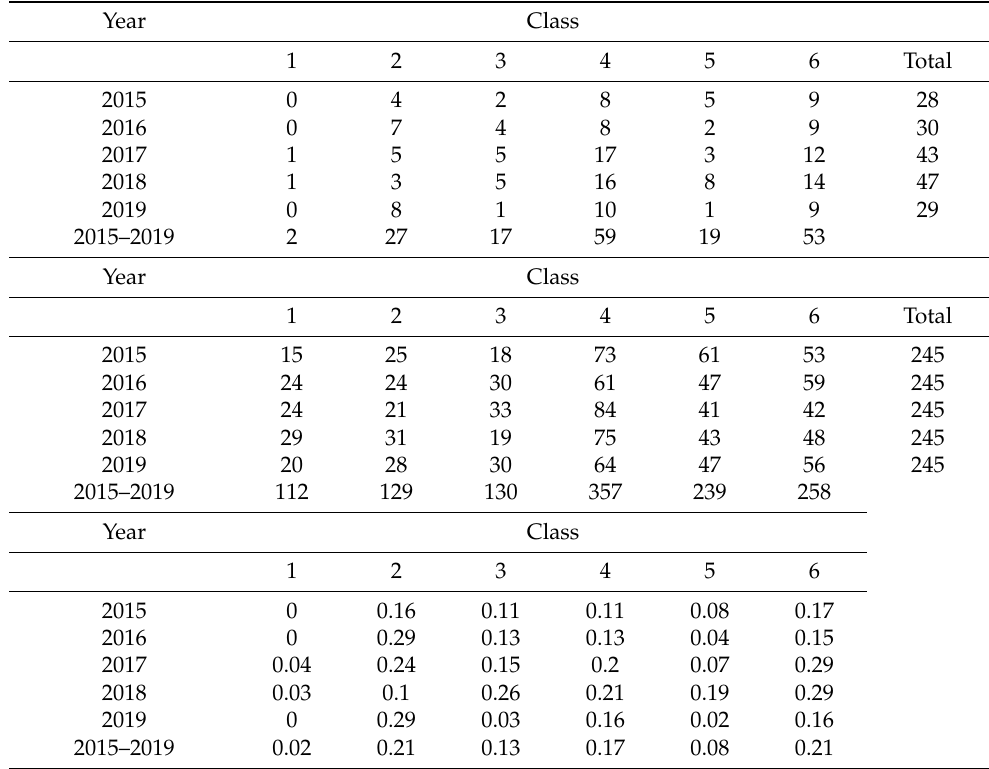
Figure 6. Description of the 850 mb wind fields for each of the six synoptic-scale classifications identified using K-means clustering analysis. Table 2. Number of days between March and October, categorized by year and synoptic case, for (top) sea breeze cases only, (middle) all days and (bottom) the fraction of days experiencing a sea